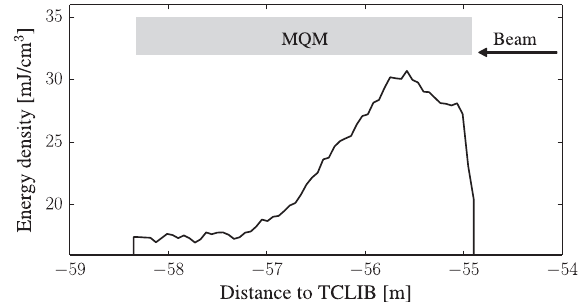
occurs.FIG. 7. FLUKA simulated peak energy density deposited in the coil during the short-duration collimation quench test. The gray box indicates the